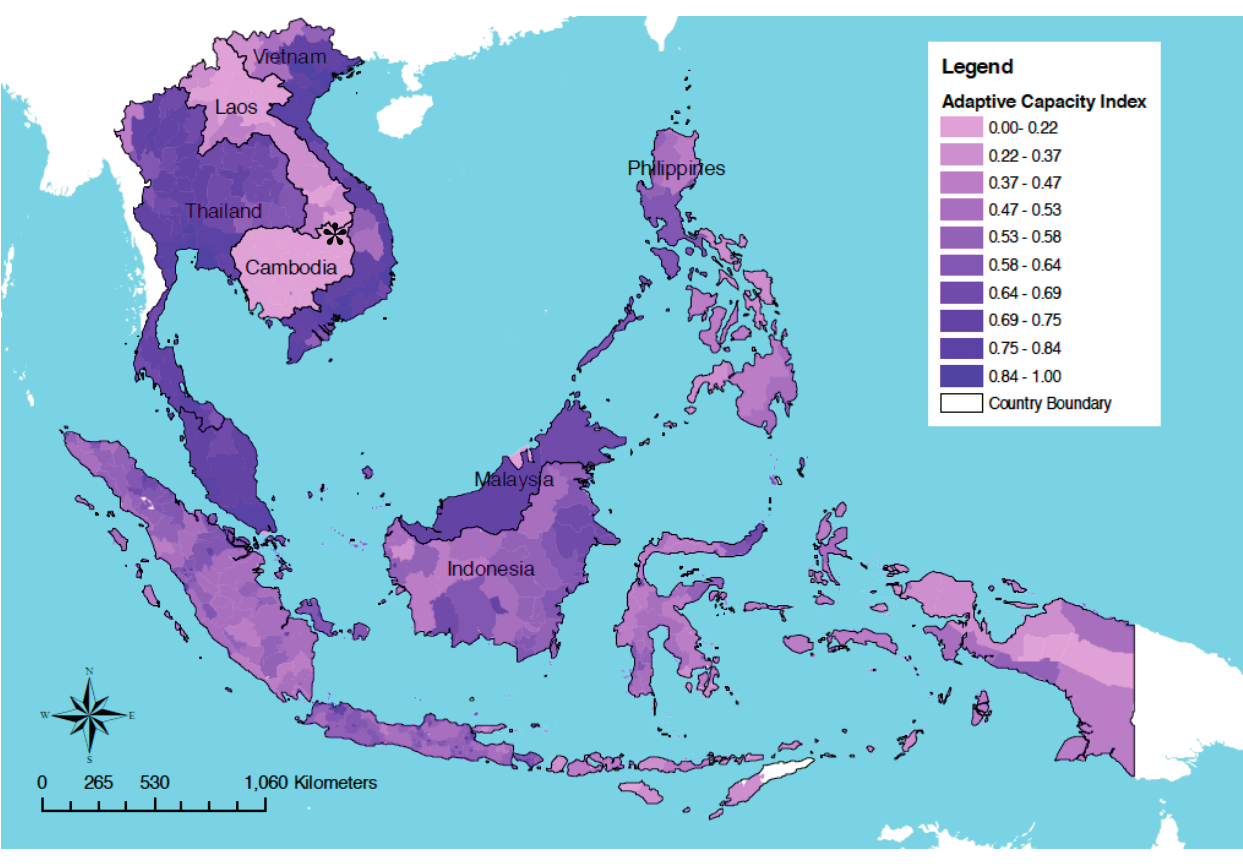
Figure 3. Adaptive capacity to climate change in Southeast Asia. Cambodia (*) and Laos have the lowest adaptive capacity in the region. Source: Reproduced with permission from Yusuf and Franciso